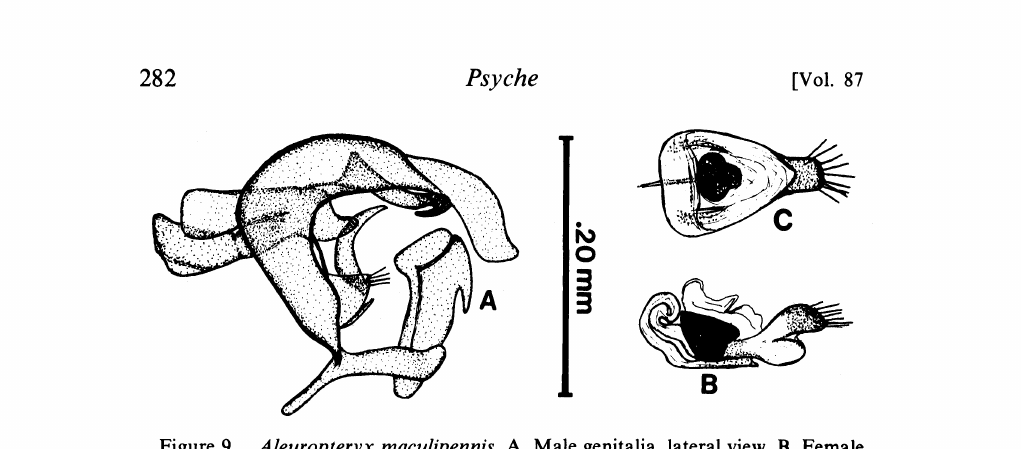
Figure 9. Aleuropteryx maculipennis. A. Male genitalia, lateral view. B. Female genitalia, lateral view. C. Female genitalia, ventral